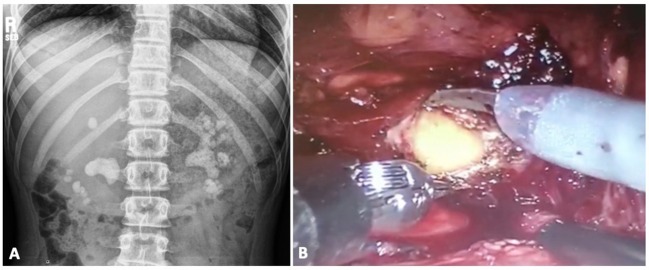
Patient with bilateral staghorn calculi and cystinuria (A) undergoes metachronous bilateral pyelolithotomies (B).